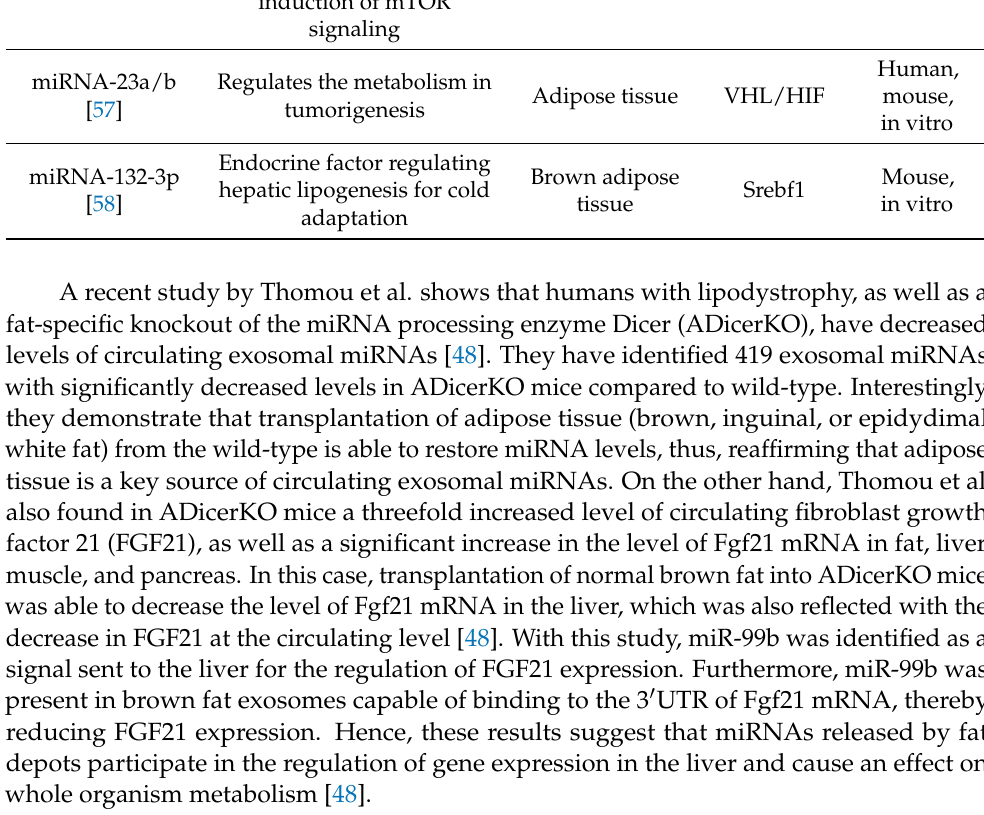
Table 1. Overview of the reviewed publications related to the characterization of the miRNA load in EVs shed by adipose tissue; miRNA type, function, tissue origin, target, species. miRNA Function(s) Tissue Origin Target(s) Positive regulator of miR-450a-5p [52] adipogenesis Inductor of glucose intolerance and insulin miRNA-155 resistance, impairs insulin [55] secretion and enhances β cell proliferation miR-99b Negative regulator of [48] FGF21 expression Capable of causing cardiomyocyte hypertrophy miR-200a through downregulation of [56] TSC1 and subsequent induction of mTOR signaling miRNA-23a/b Regulates the metabolism in [57] tumorigenesis Endocrine factor regulating miRNA-132-3p hepatic lipogenesis for cold [58] adaptation